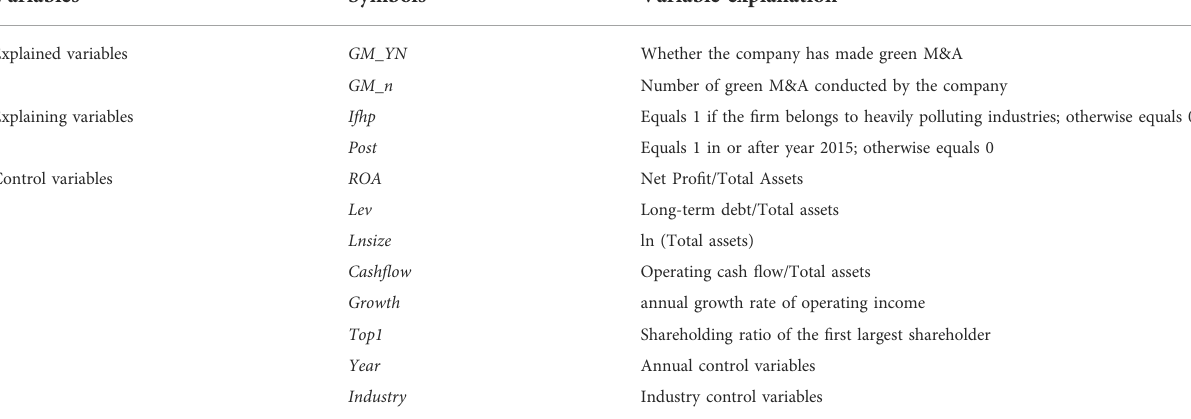
TABLE 1 Variable de fi nitions.